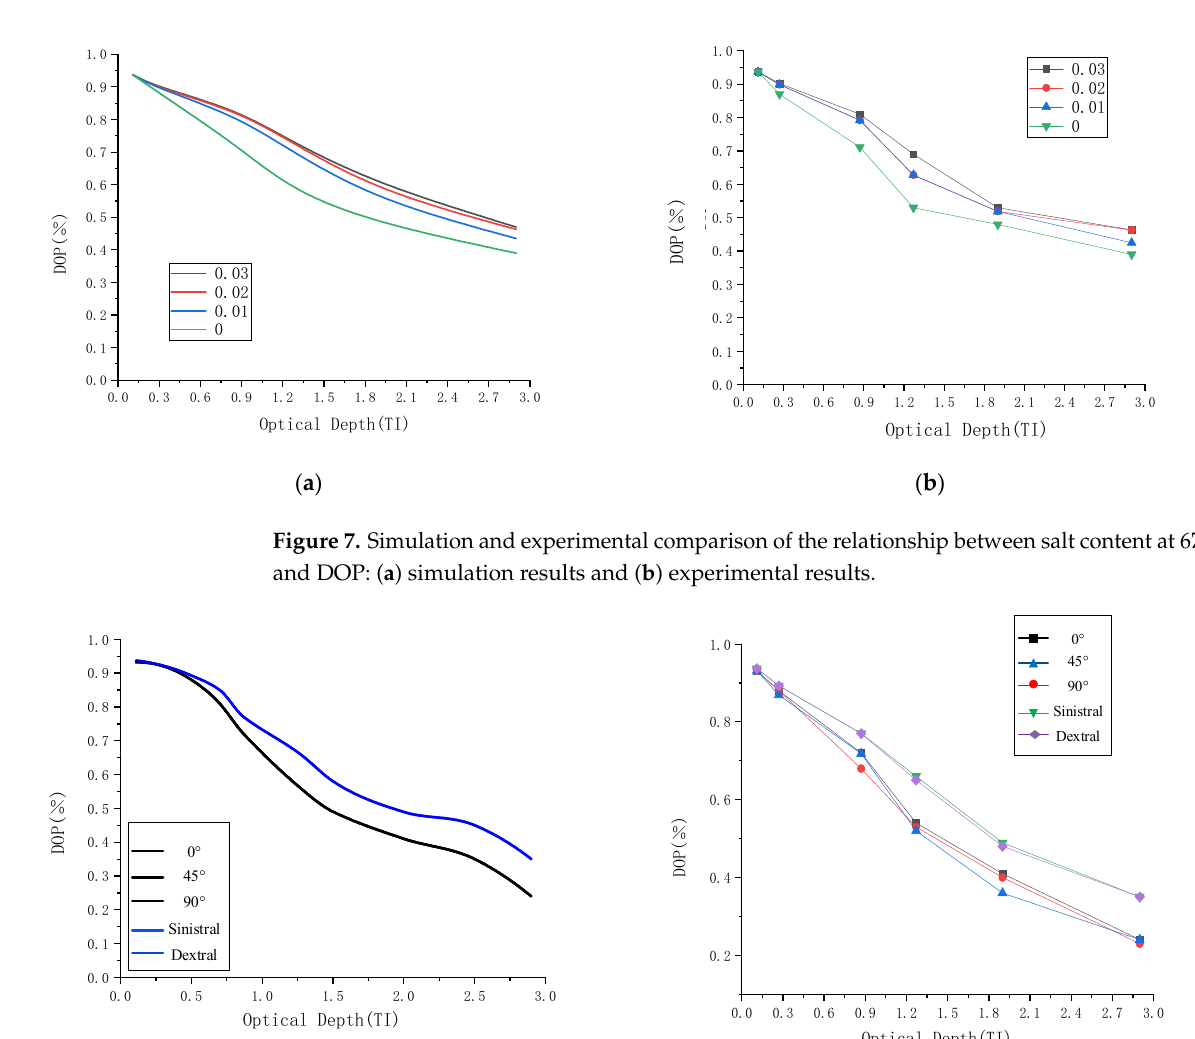
Figure 9. λ = Simulation and experimental comparison of DOP change of 532 nm polarized light: ( a ) simulation results and ( b ) experimental results.